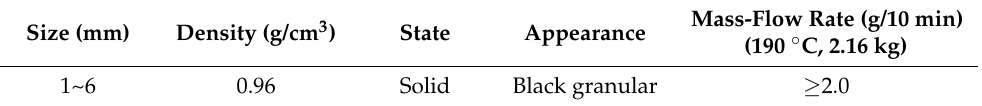
Mass-Flow Rate (g/10 min) (190 ◦ C, 2.16 kg)